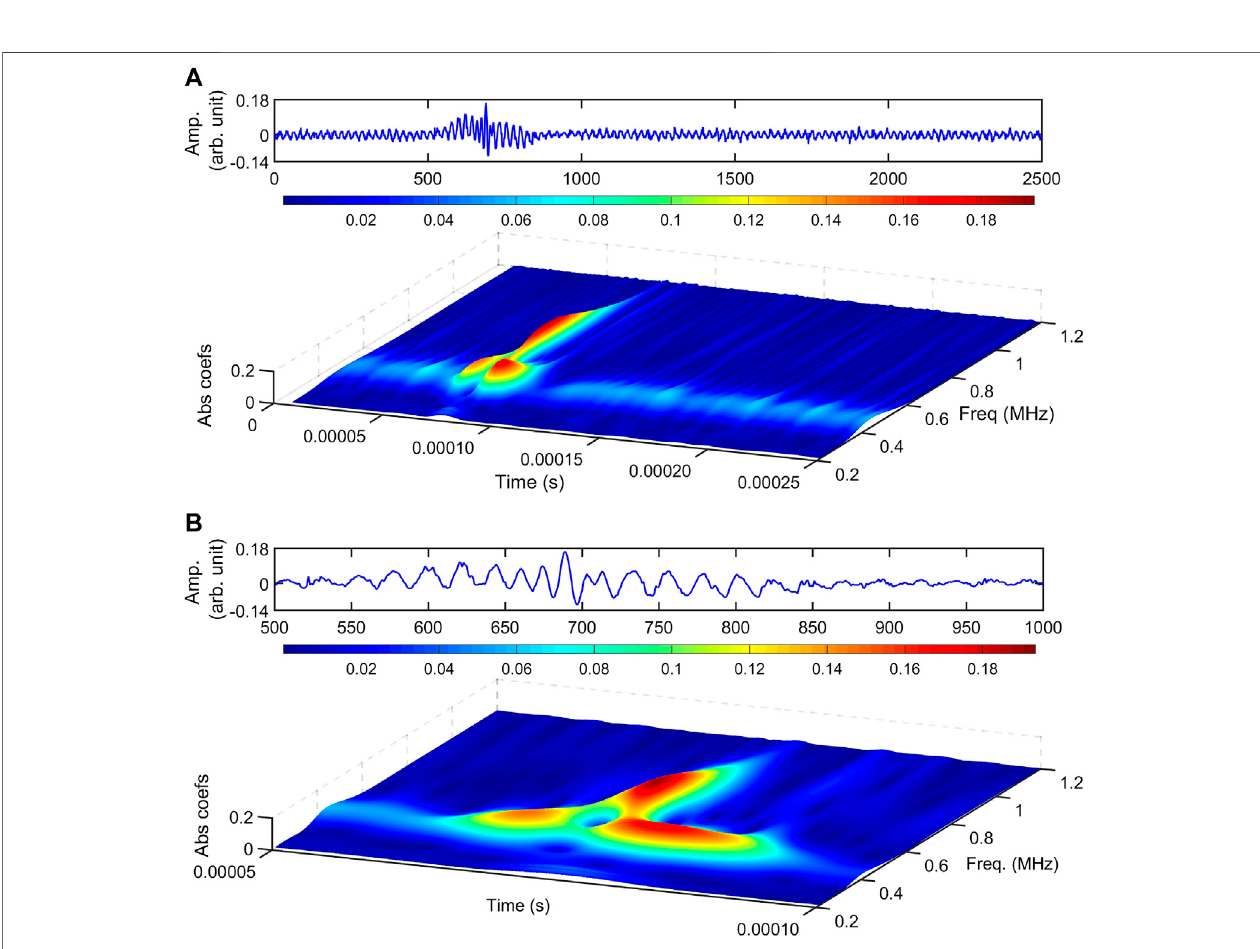
Frontiers in Physics |